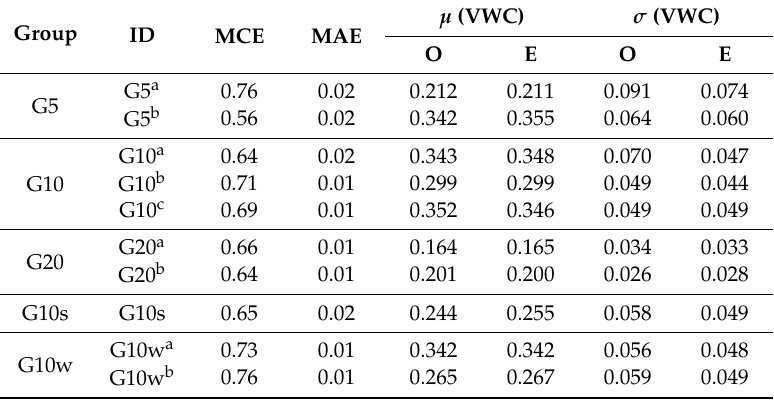
Table 4. MCE, MAE, mean ( µ ) and standard deviation ( σ ) from observed (O) and estimated (E) volumetric water content (VWC) during calibration period (rainy season